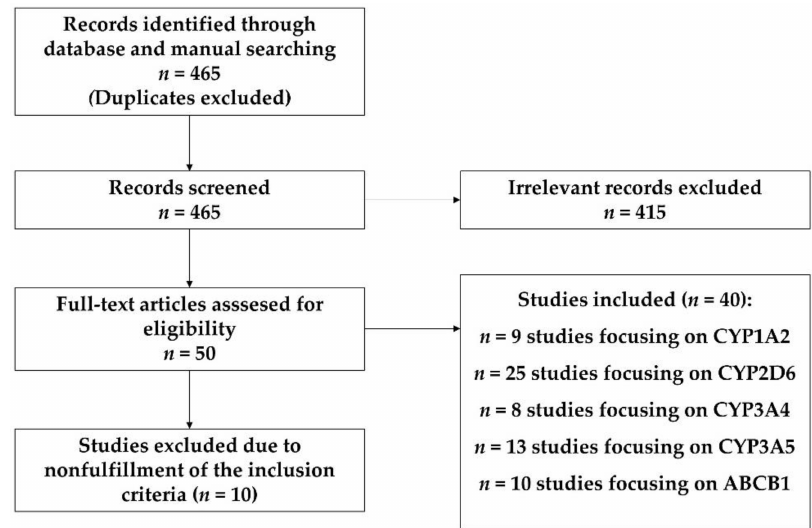
Figure 1. PRISMA